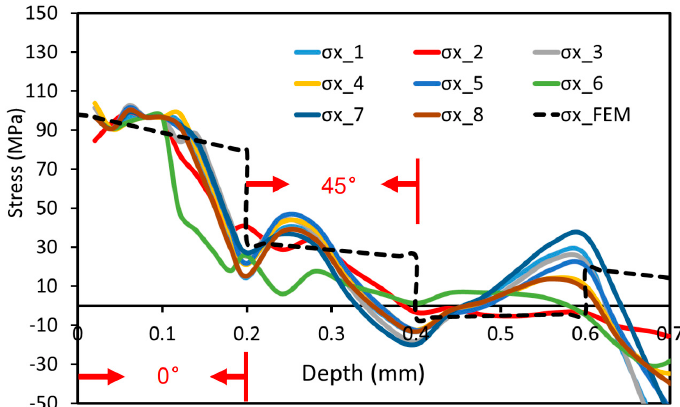
Figure 13. Experimental setup used for validation of the residual stress profiles. Figure 14. Validation of the residual stress measurements in the multidirectional CFRP sample based on the assessment of stresses introduced by superimposed load and a direct comparison to FEA. Solid lines show experimentally determined bending stress, while the dashed line illustrates the FEA results. See text for details.